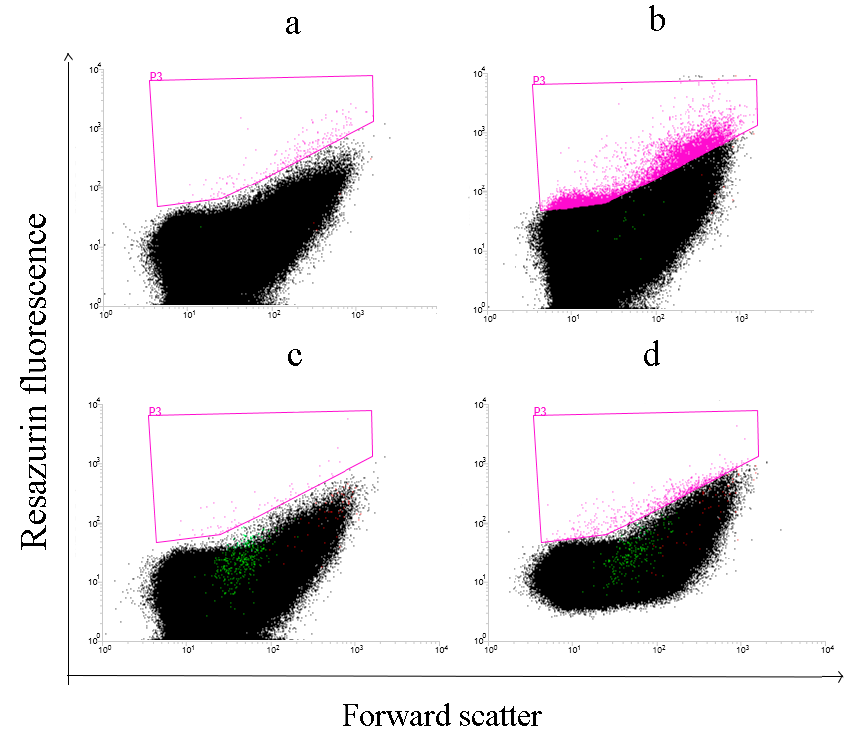
Figure 6. Flow cytometry analysis of the resazurin assay for cellobiose dehydrogenase activity in double emulsions. ( a ) Emulsions with resazurin; ( b ) resazurin plus soluble enzyme; ( c ) resazurin plus cells not expressing CDH; ( d ) resazurin plus cells expressing tmCDH. The plots show bivariate histograms of forward scattering and resorufin fluorescence.